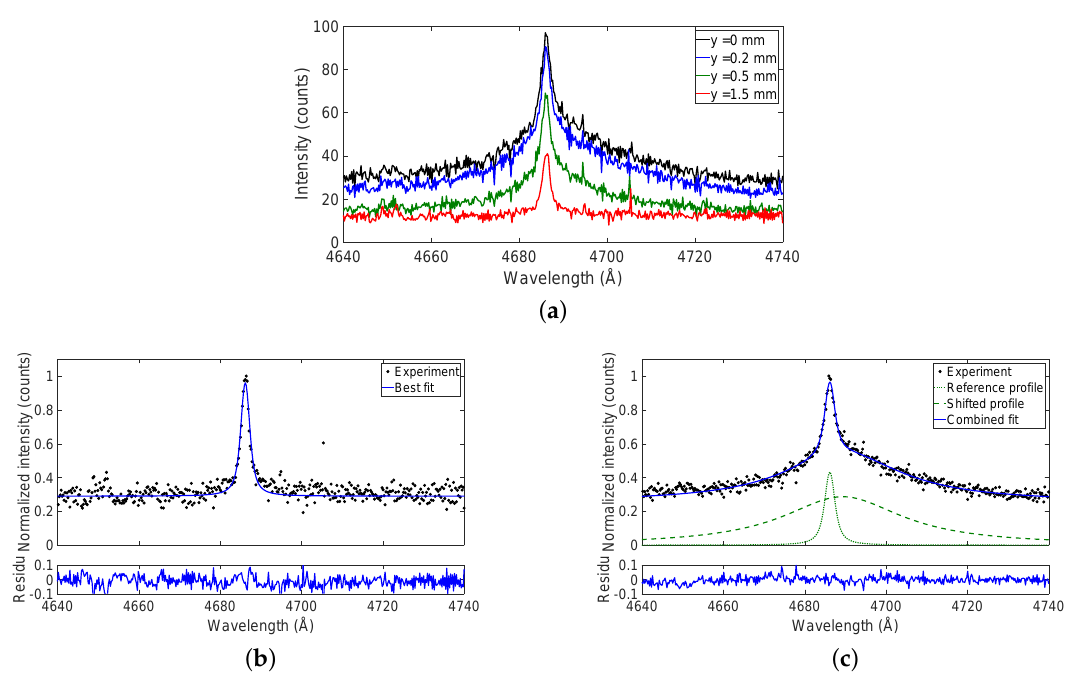
Figure 3. ( a ) Spectral lineouts at different y positions; ( b ) spectral lineout at y = 1.5mm and ( c ) at y = 0 with their best